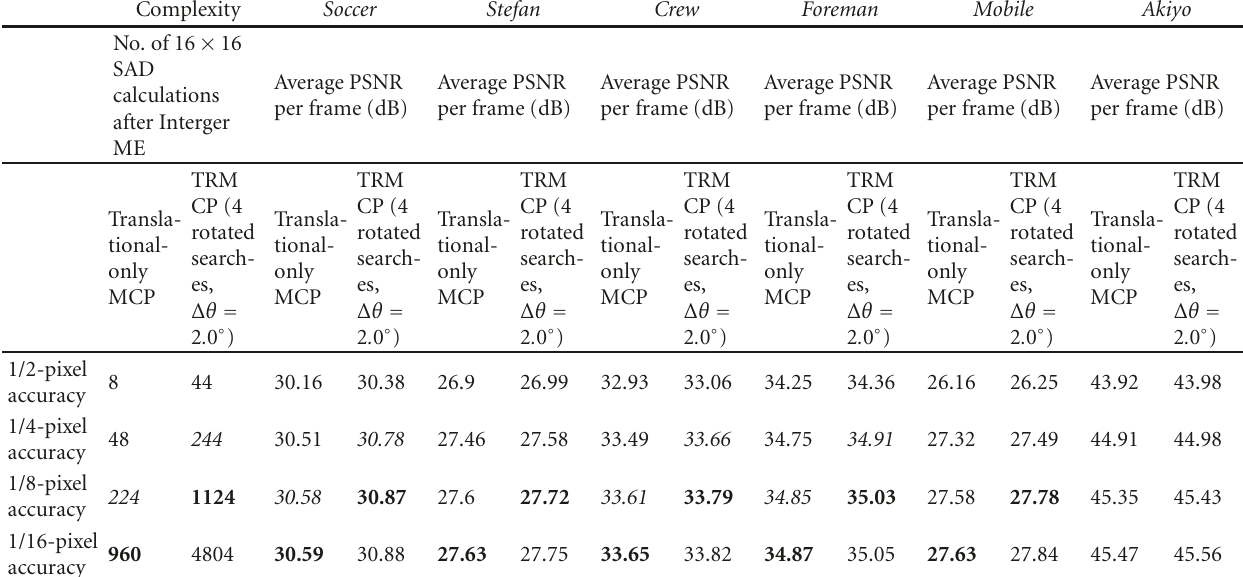
Table 4: Comparison of computational complexity and prediction accuracy.